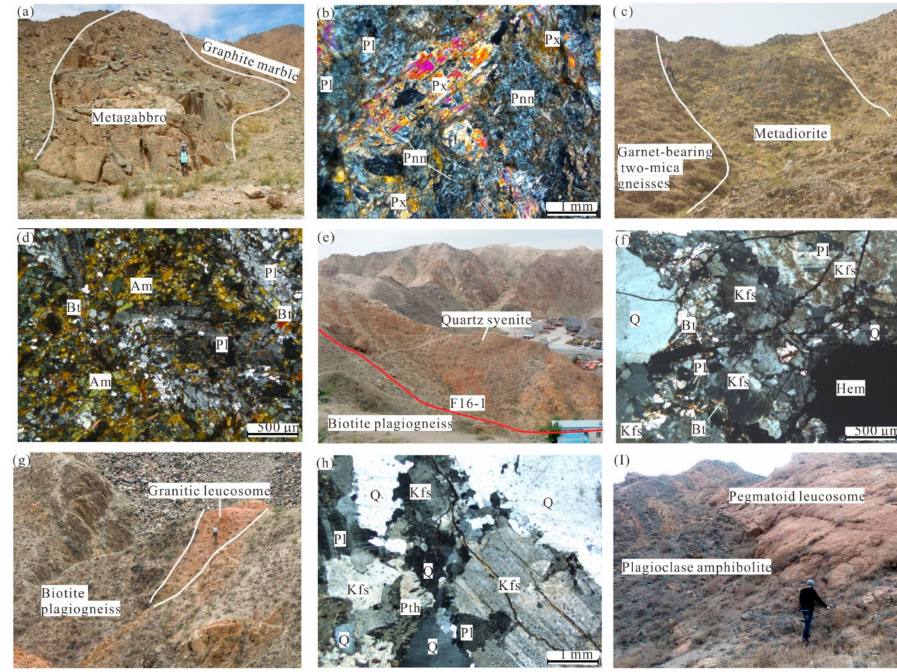
Figure 3. Field aspects and photomicrographs of Paleoproterozoic rocks: ( a ) metagabbro dike intruding graphite marble; ( b ) metagabbro sample JZ-15 (perpendicular polarized light); ( c ) metadiorite dike intruding garnet-bearing two-mica gneisses; ( d ) metadiorite sample JC-116 (perpendicular polarized light); ( e ) quartz syenite in fault contact with the biotite plagiogneiss; ( f ) quartz syenite sample JZ-30 (perpendicular polarized light); ( g ) Granitic leucosome vein intruding biotite plagiogneiss; ( h ) Granitic leucosome sample JZ-36 (perpendicular polarized light); ( i ) gradational contact relationship